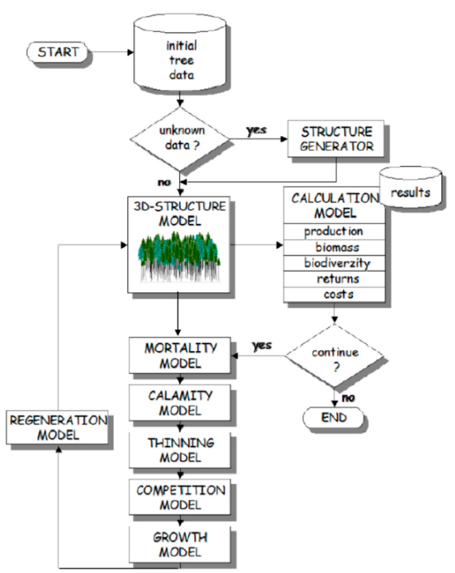
Figure 2. Information flow and modular structure of growth simulator SIBYLA [48].